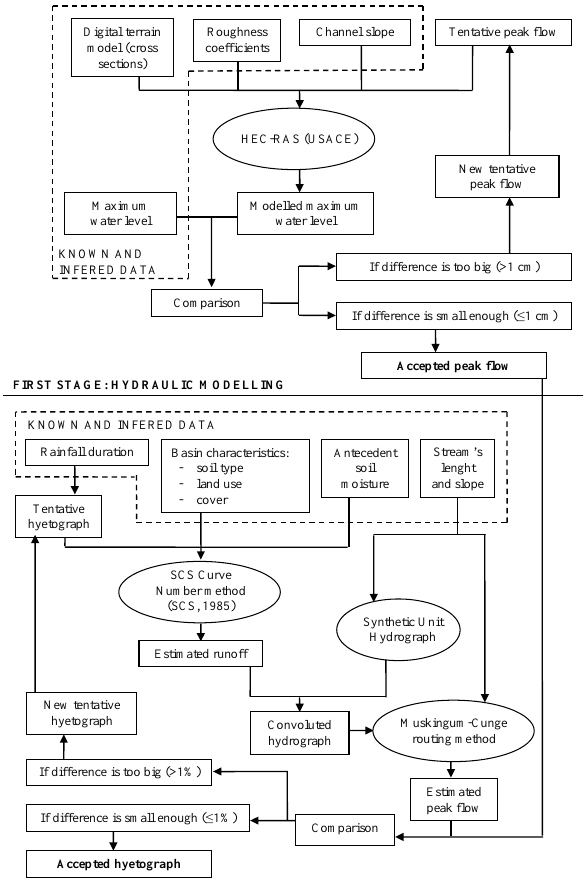
Fig. 6. Methodological procedure for the calculation of the event’s peak flow and hyetograph.